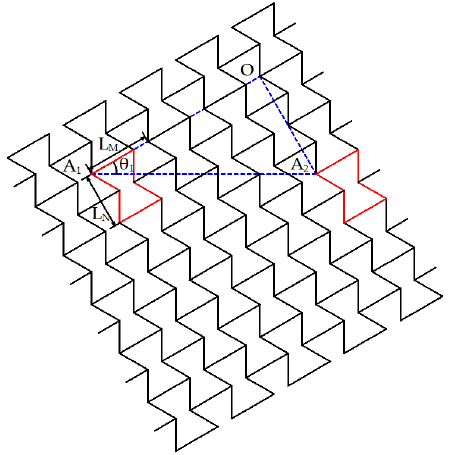
Figure A1. θ 1 re-entrant honeycomb layer.